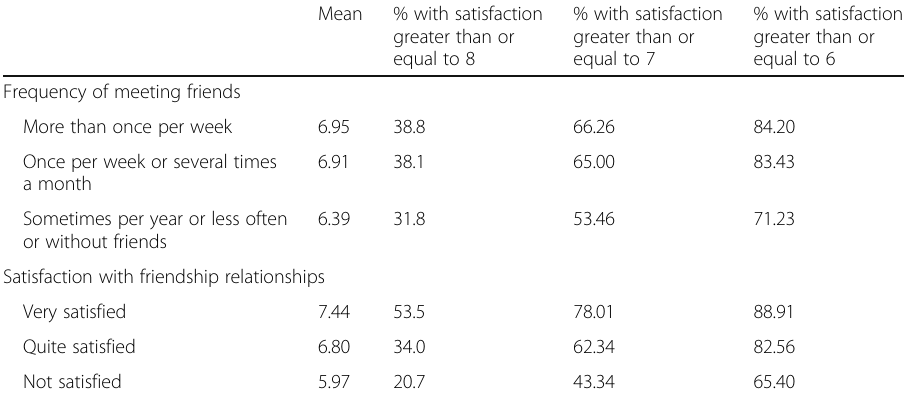
Table 2 Some descriptive indicators of an individual ’ s life satisfaction according to their friendship